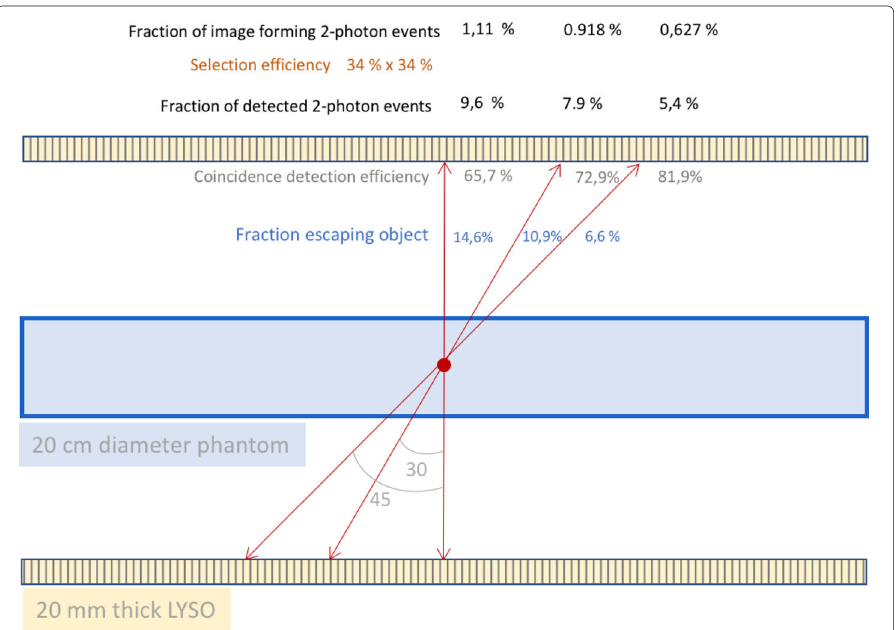
Fig. 4 The influence of the oblique angle on attenuation and detection efficiency in a long axial FOV scanner